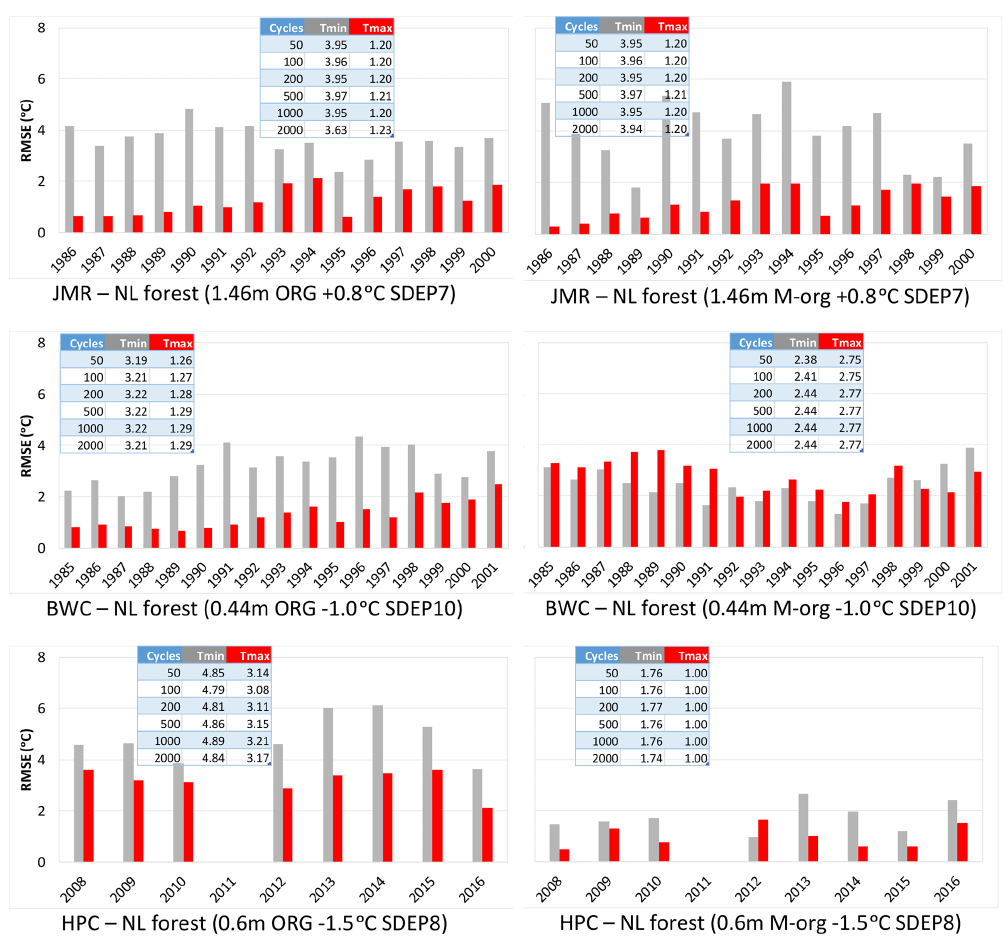
Figure 11. Time series of RMSE of simulated envelopes at all three sites at the end of 2000 cycles. Two organic configurations were used for each site using the SC2 layering scheme. Table insets show the change in mean RMSE over the period of the available record for simulations initiated after the number of spin-up